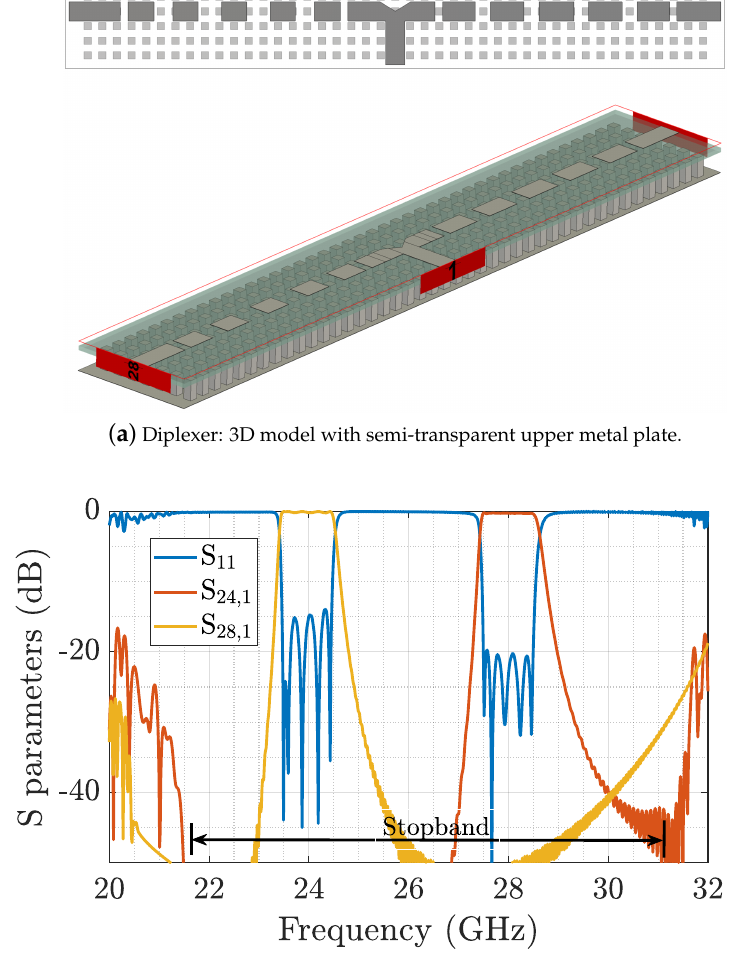
Figure 4. Diplexer design with lossless